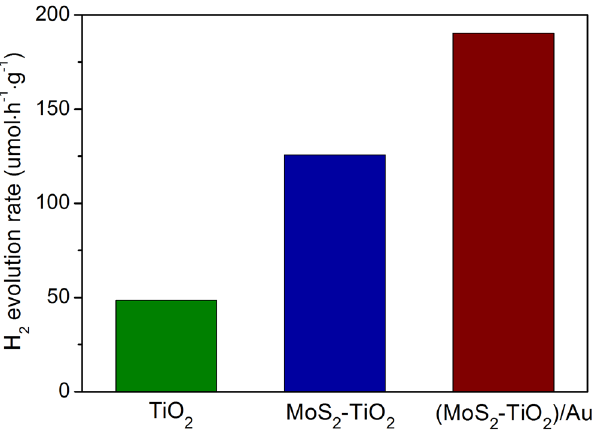
Figure 6. Photocatalytic hydrogen production activities of TiO 2 , MoS 2 -TiO 2 , (MoS 2 -TiO 2 )/Au electrodes under full spectrum in the aqueous solution containing 20% methanol as sacrificial